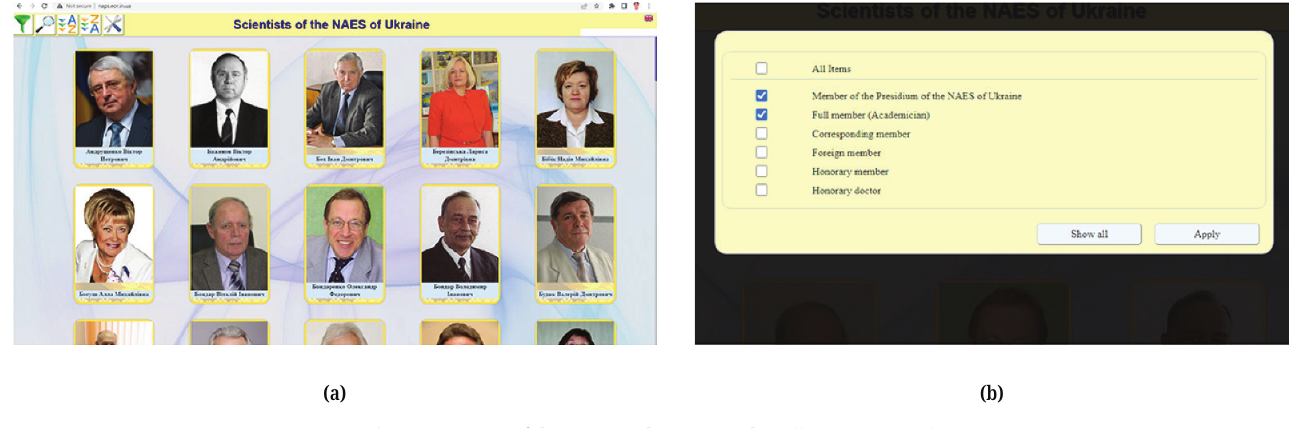
Fig. 6. Scientists of the NAPS web resource